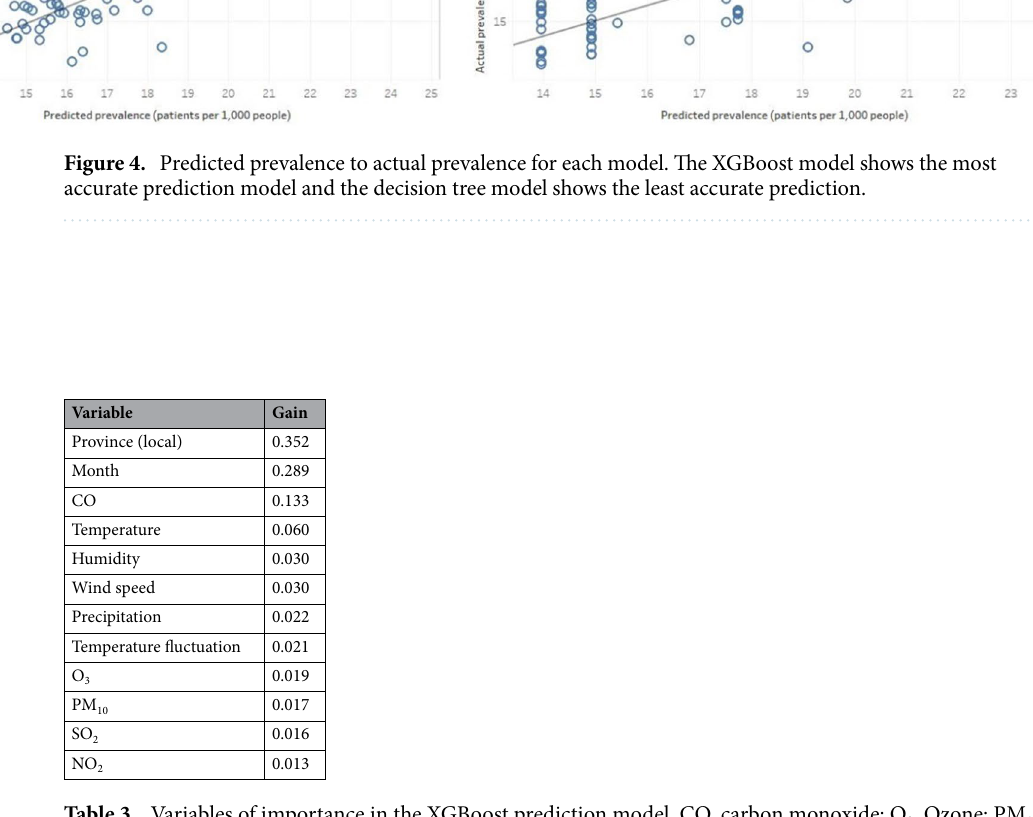
Table 3. Variables of importance in the XGBoost prediction model. CO, carbon monoxide; O 3 , Ozone; PM 10 , levels of particulate matter with aerodynamic diameter < 10 μm; SO 2 , sulfur dioxide; NO 2 , nitrogen